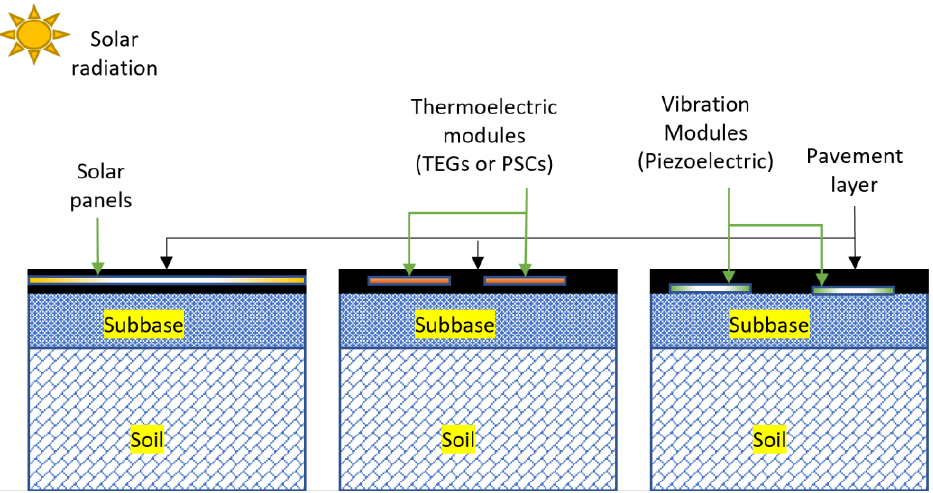
Figure 1. Schematic diagram illustrating pavement energy harvesting technologies [17]. (This drawing was created by the authors).